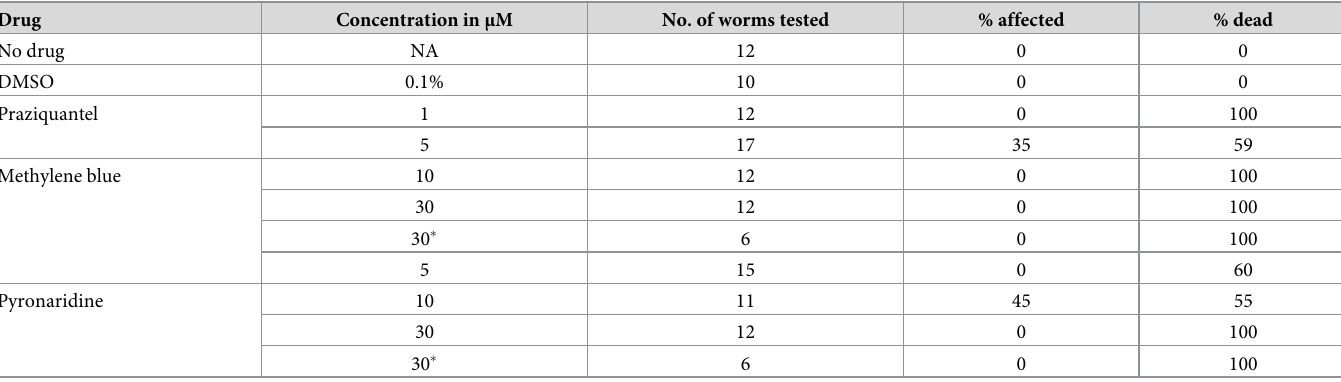
Table 2. Drug activity against ex vivo adult worms (step 2).